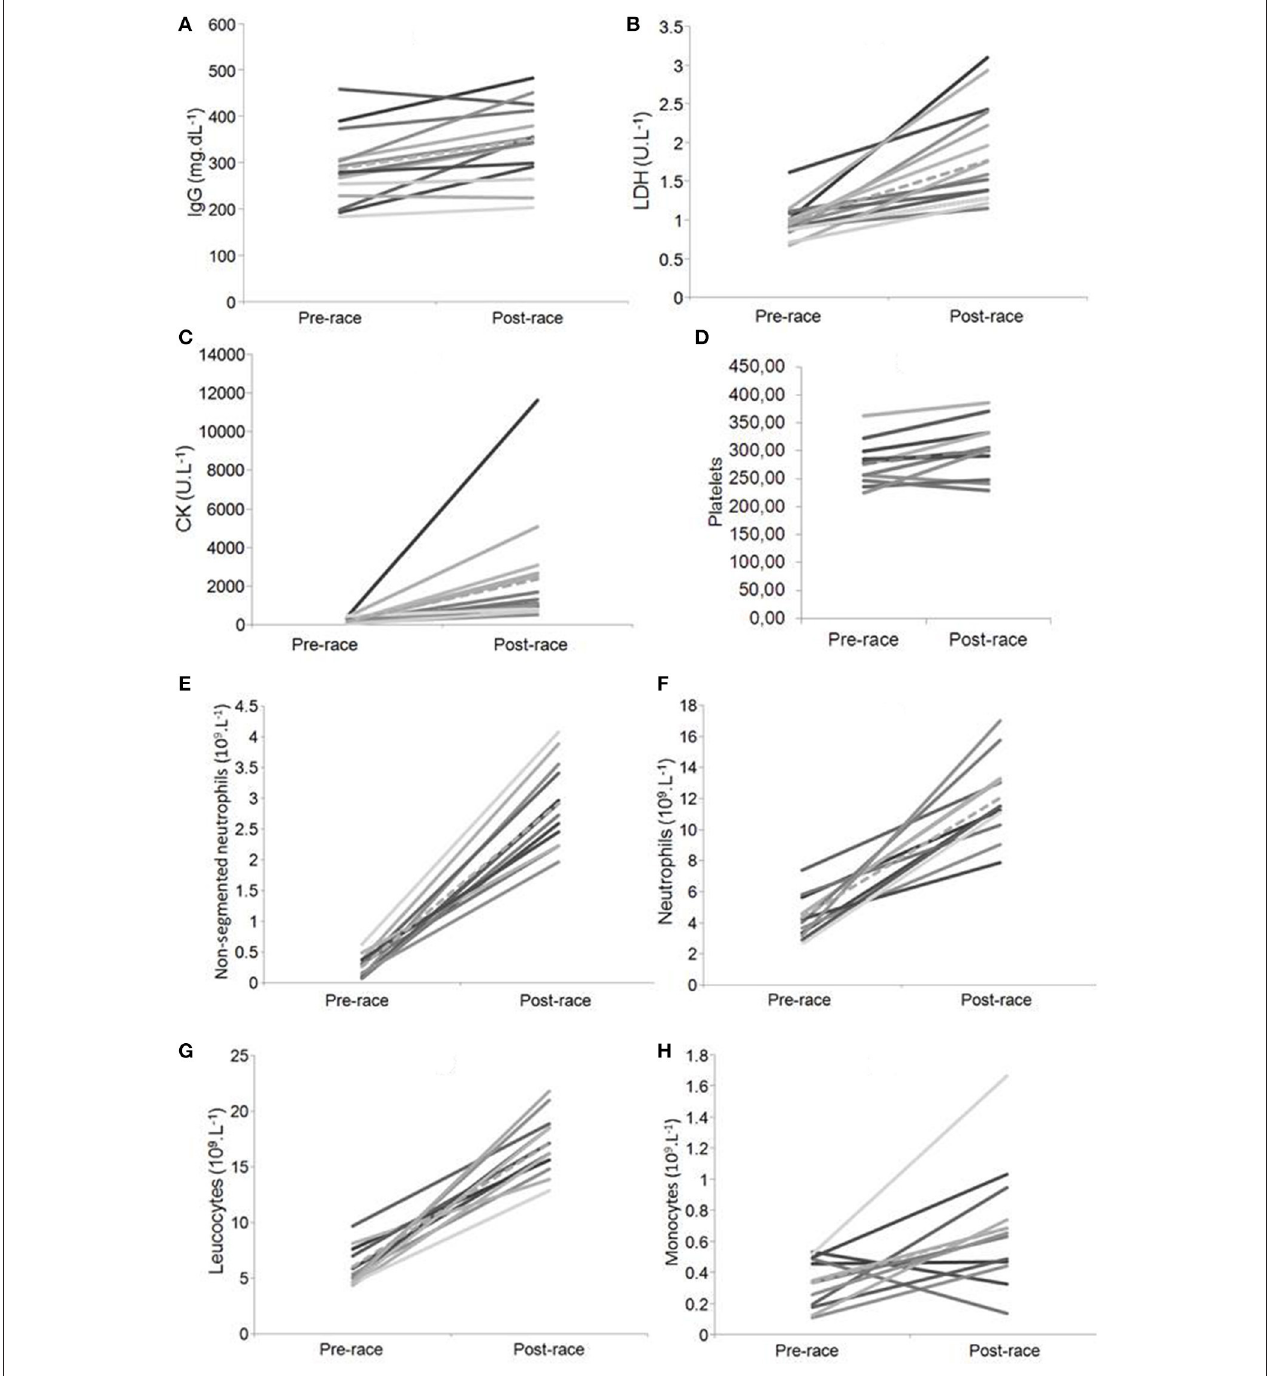
FIGURE 1 | Statistically significant changes in pre- and post-race levels of IgG, LDH, CK, platelets, number of non-segmented (immature) neutrophil granulocytes, neutrophil granulocytes, leukocytes *Note. Dashed line–Mean value; (A) IgG, (B) LDH, (C) CK, (D) Platelets, (E) Non-segmented (immature) neutrophils, (F) Neutrophils, (G) Leukocytes, (H)